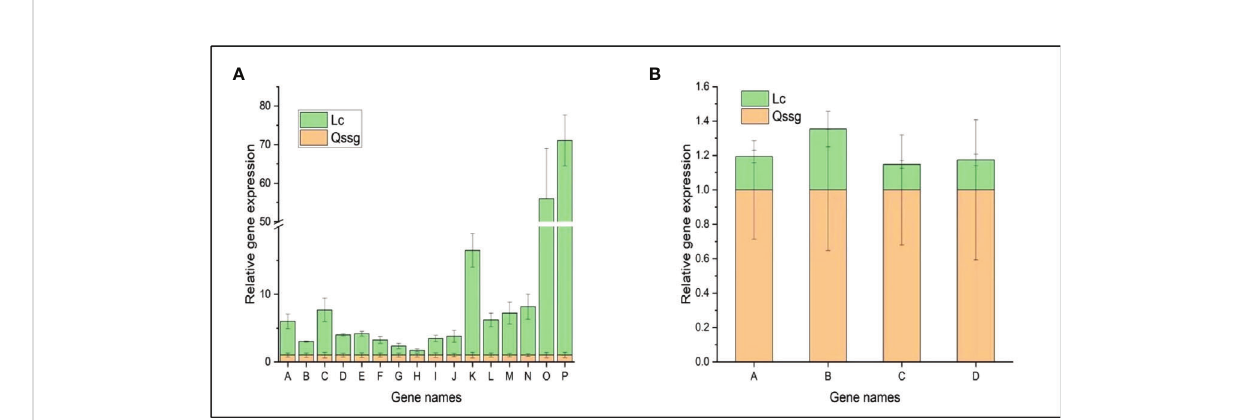
FIGURE 6 qRT PCR con fi rmation map of the differential fl avonoid-related gene expression in Qssg and Lc Actinidia arguta Sieb.Zucc. fruits. (A) The relative expression levels of 16 structural genes regulating fl avonoids in Lc varieties were higher than those in Qssg varieties. (B) The relative expression levels of the four structural genes regulating fl avonoids in Lc varieties were lower than those in Qssg varieties. Most of the selected genes showed a high correlation between the qPCR and RNA-seq datasets, thus validating the transcriptome data. ( 2^- △△ Ct data value of the internal reference gene is ACTIN).